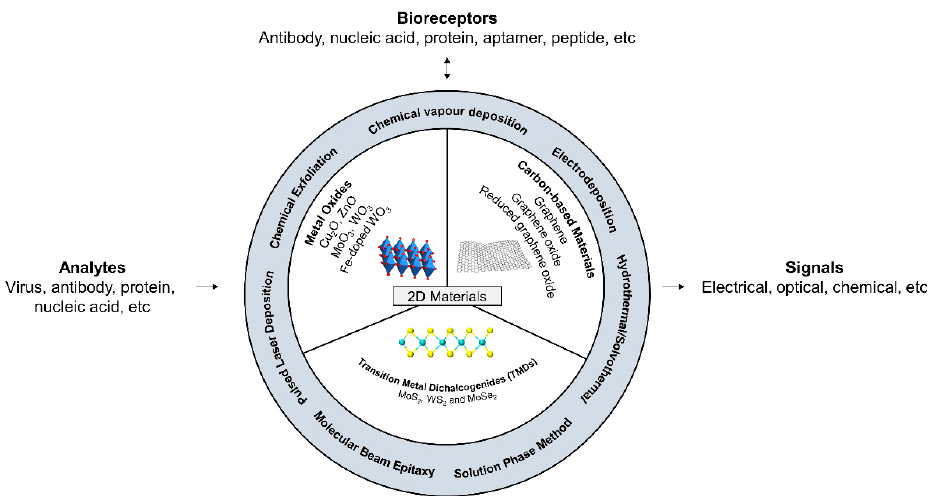
Figure 3. Schematic illustration of general strategies for fabricating 2D materials, mainly transitions metal dichalcogenides (TMDs), carbon-based materials, and metal oxides as biosensors engaged with bio-receptors to detect various analytes and generate signals corresponding to the concentra- tion of analytes.